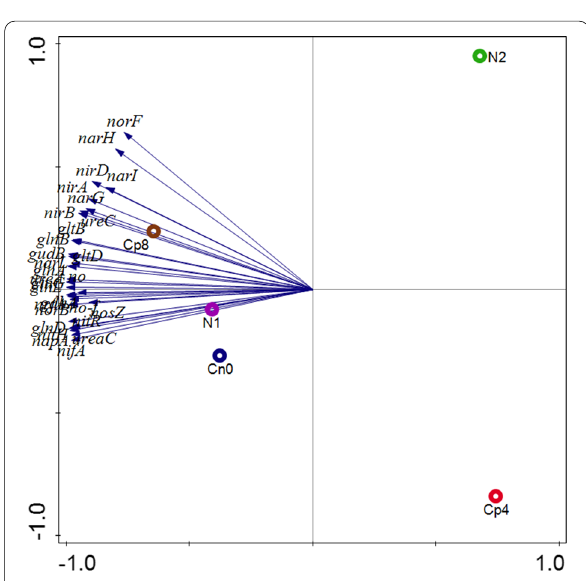
Fig. 5 Principal component analysis of the nitrogen cycling genes obtained under fertilization and unfertilized maize rhizosphere soil samples. Axis 1 and Axis 2 explains 94.89% and 3.74% variations. The abbreviated symbols are explained in Fig.